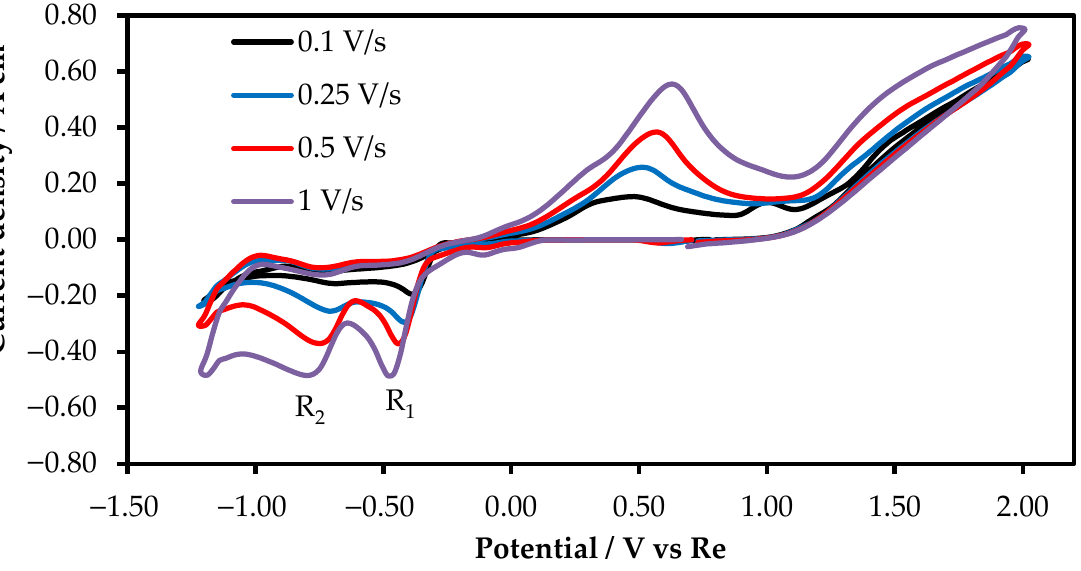
Figure 3. Cyclic voltammogram of KReO 4 in molten KF-KBF 4 -B 2 O 3 on a platinum wire electrode. Scan rate: 100 mV/s; RE:Re; CE:Re.